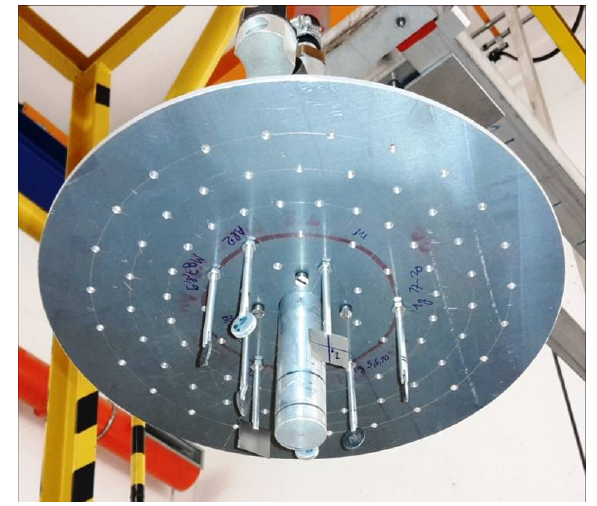
Figure 2. Irradiation of the activation foils using 252 Cf